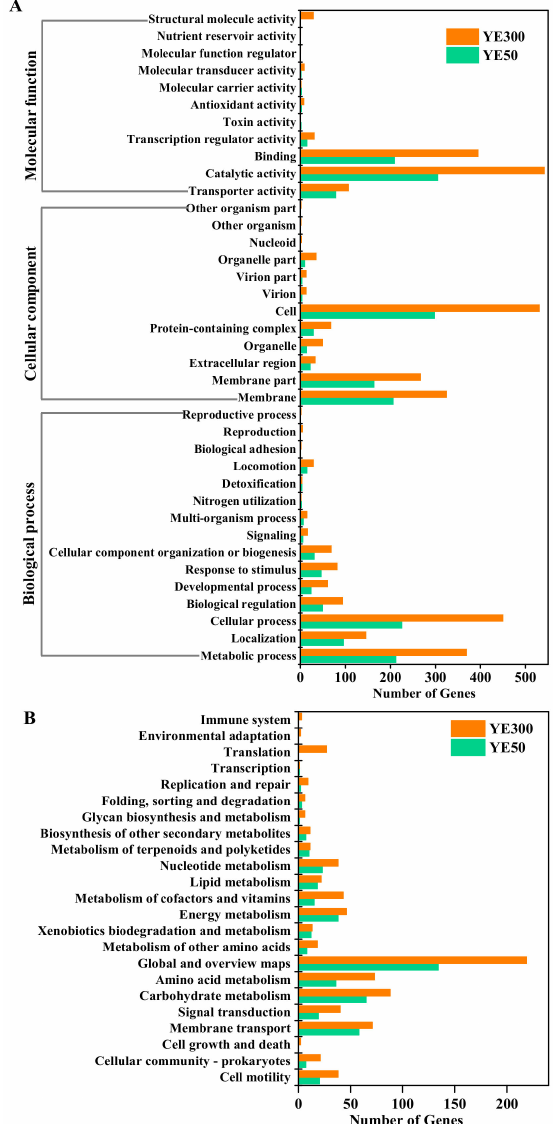
Figure 3. The Gene-Ontology terms ( A ) and the KEGG pathway ( B ) analysis of differential expressed genes (DEGs) for JD-014 against low and high concentrations of nitrate (YE50 and YE300) during denitrification process. The control was incubated within media without